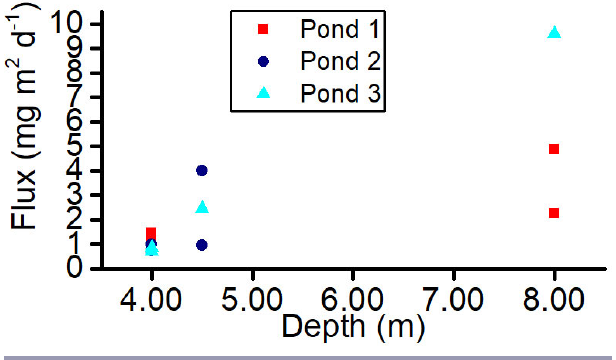
Fig. 3 . Total phosphorus fluxes estimated for 13 cores collected in pond 1, pond 2, and pond 3 at depths indicated.